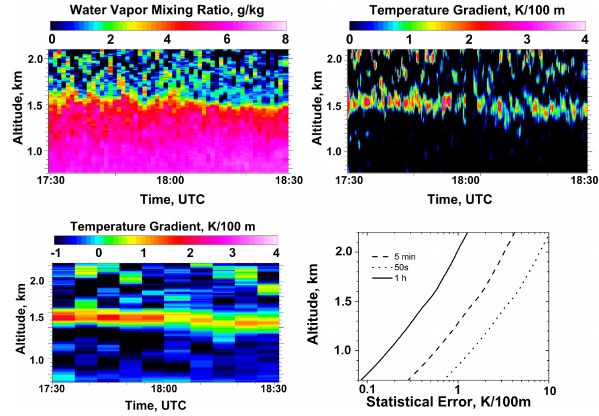
Figure 14. Detail from Fig. 13 of the time period from 17:30 to 18:30UTC on 18 May. Upper left panel: water vapor mixing ratio with 1min resolution; lower left panel: temperature gradient with 5min; and upper left panel: 10s profiles and 50s gliding time av- erage. Lower right panel: statistical error of temperature gradient